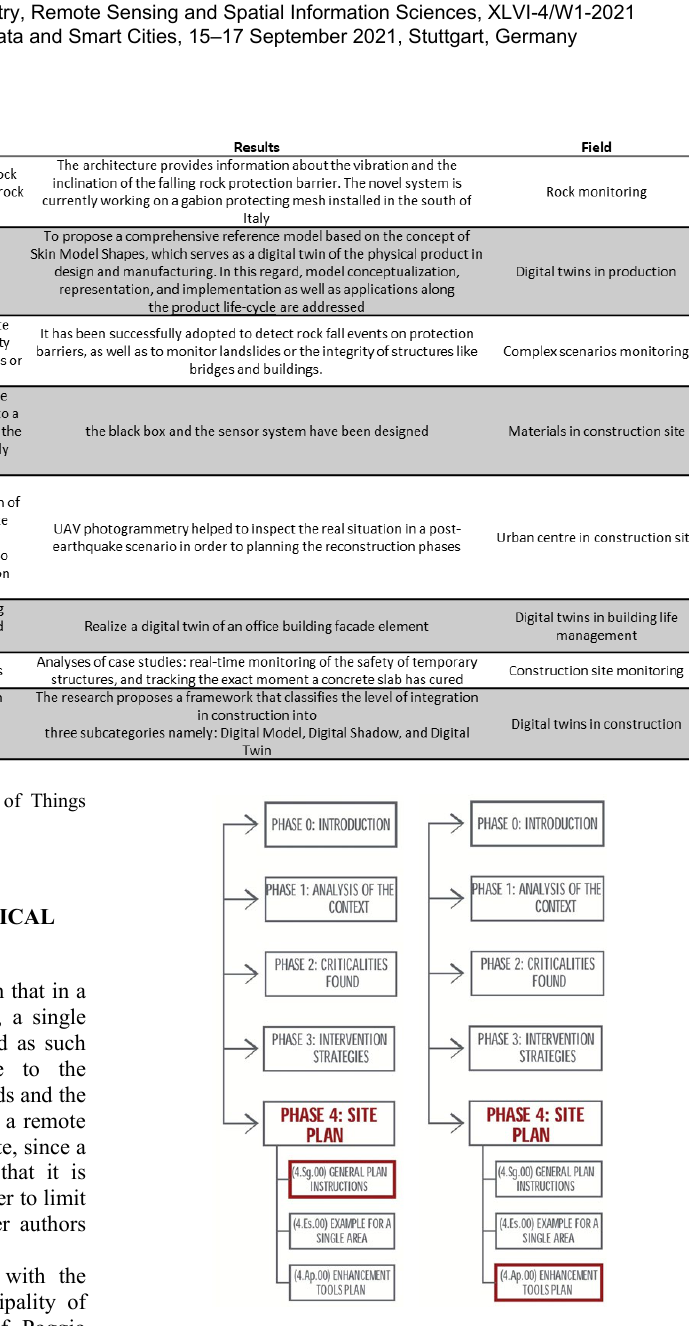
Figure 2. Methodological path. The flow chart rappresent the methodological approach to research. The topics covered in this text are highlighted in red.